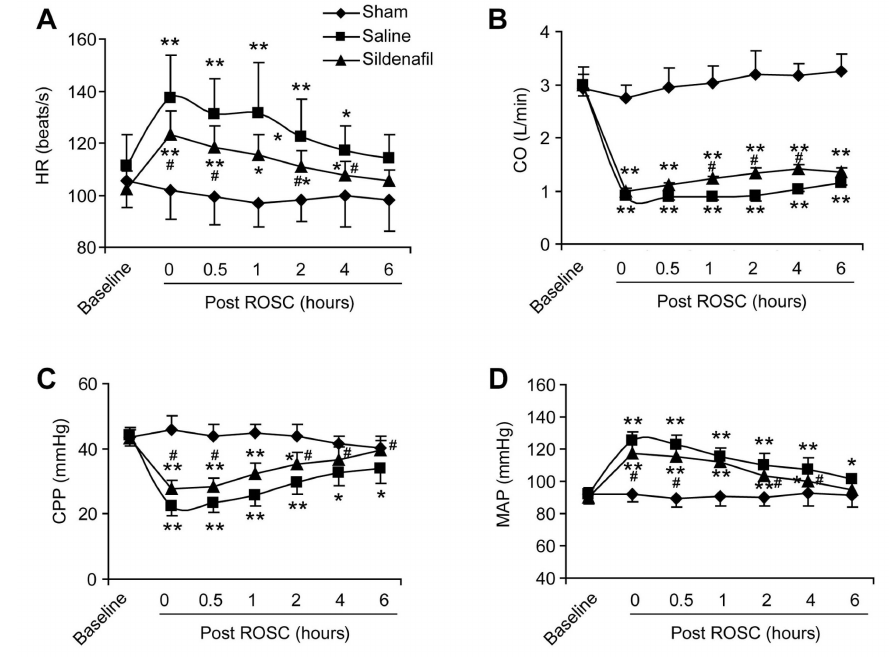
Figure 2. Cardiac functions of pigs after post-resuscitation in sham, saline, and sildenafil-treated groups. The heart rate ( A ) HR (beats/s), cardiac output ( B ) CO (L/min), coronary perfusion pressure ( C ) CPP (mmHg), and mean aortic pressure ( D ) MAP (mmHg) were monitored at 0, 0.5, 1, 2, 4, and 6 h after ROSC. * p < 0.05 vs. Sham, ** p < 0.01 vs. Sham, # p < 0.05 vs. Saline. n = 6–10 per group.